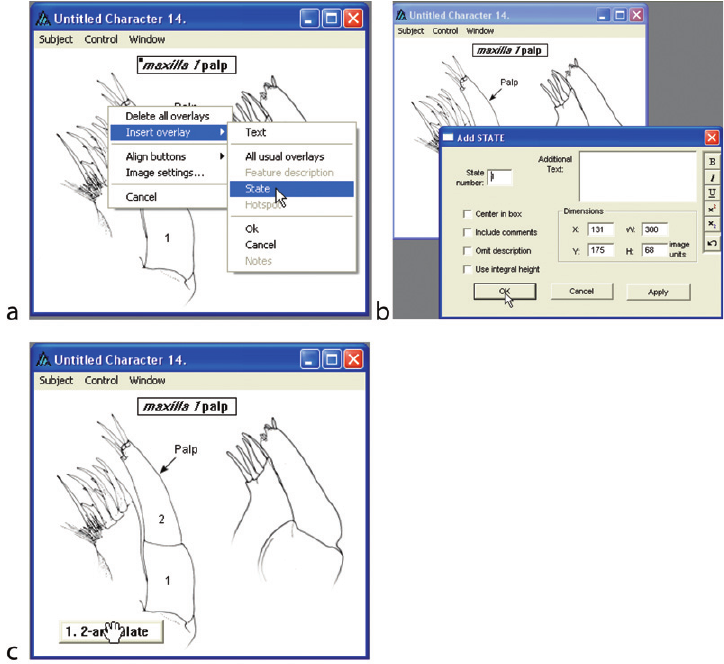
Figure 19a–c. Creating an overlay for character state